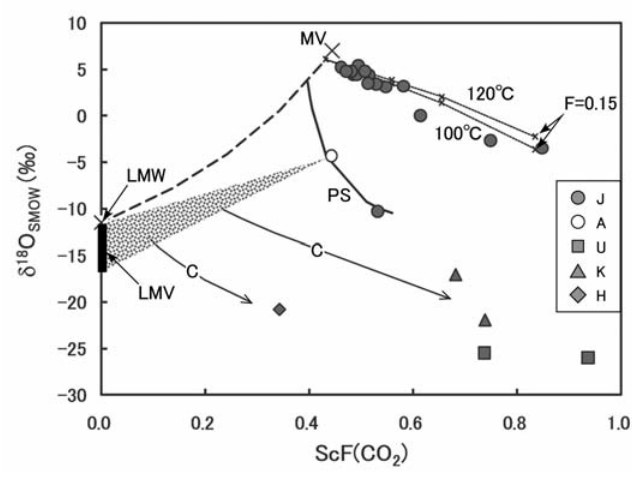
Figure 10. Correlation between the δ 18 O values of H /H O ratios in the fumarolic gases. Bold dashed curve, mixing line CO 2 2 between the MV and the LMW. The LMV represents the vapor generated from the LMW at 100 °C. Shaded region, mixture between the LMV and a gas similar to that from site A. Solid curve (labeled PS), composition of primary steam. Thin dashed curves and solid curves, trends of the partial condensation of the water vapor phase, for which F is the fraction of water vapor remaining after partial condensation.